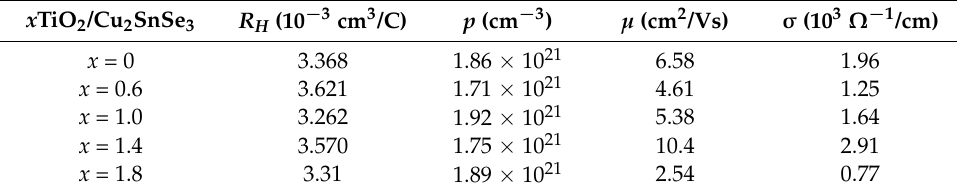
Figure 6. Temperature dependence of electrical conductivity for the TiO 2 /Cu 2 SnSe 3 composites. Table 2. The physical parameters of the x vol % TiO 2 /Cu 2 SnSe 3 composite at room temperature. x TiO 2 /Cu 2 SnSe 3 R H (10 − 3 cm 3